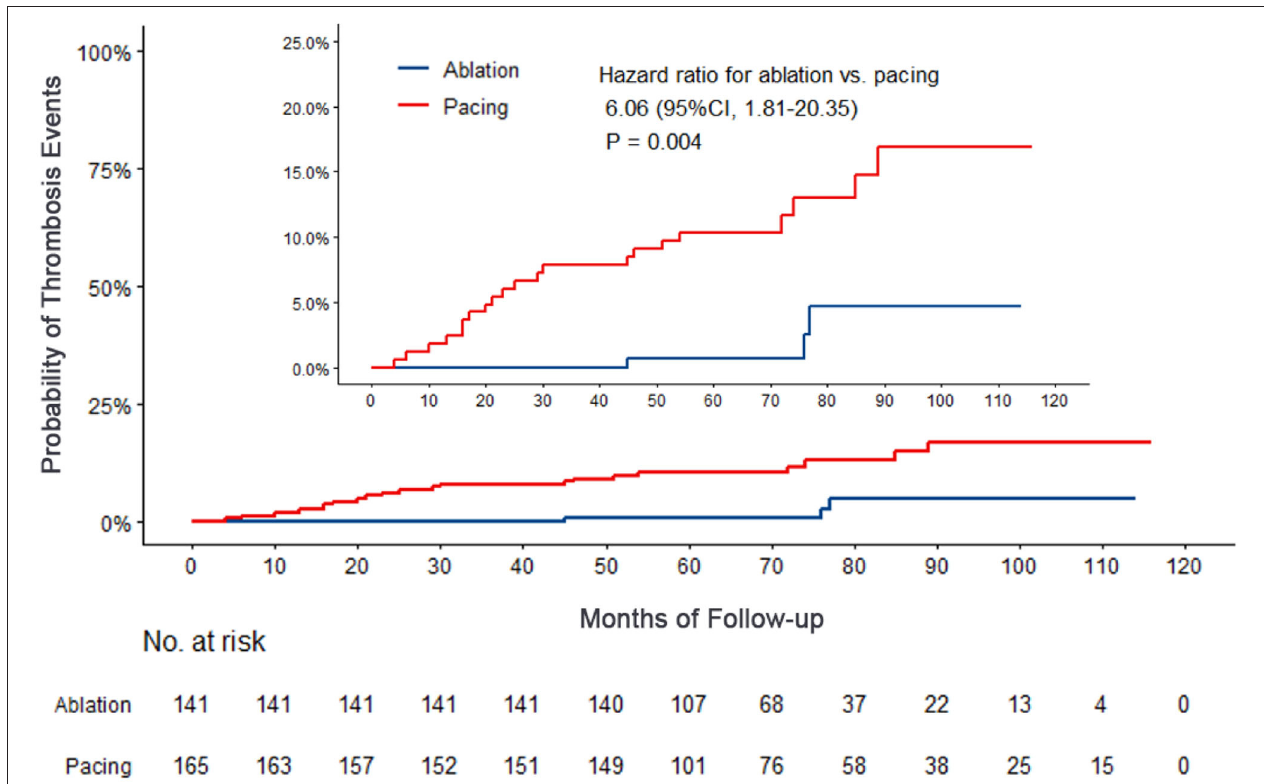
FIGURE 4 | Kaplan–Meier curves comparing probability of thrombosis events. Month 0 is the time of the baseline visit.